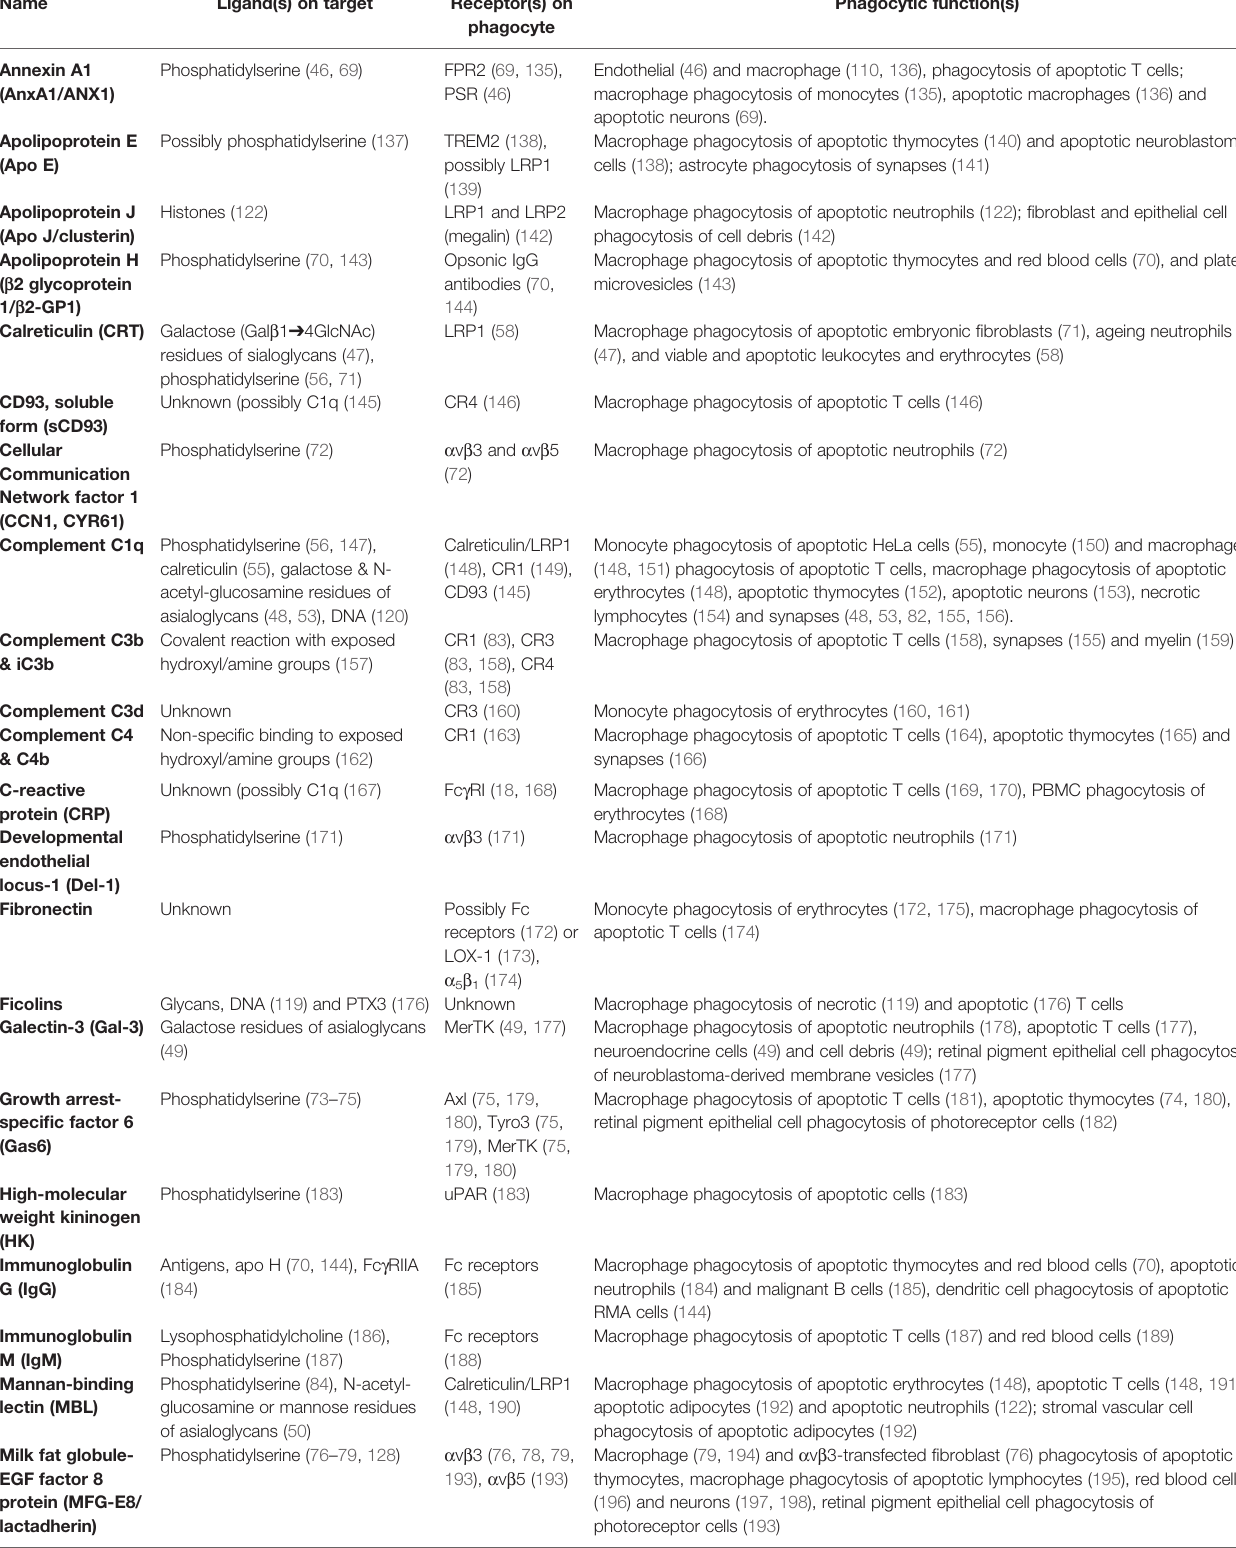
TABLE 3 | Opsonins for phagocytosis of mammalian cells/sub-cellular